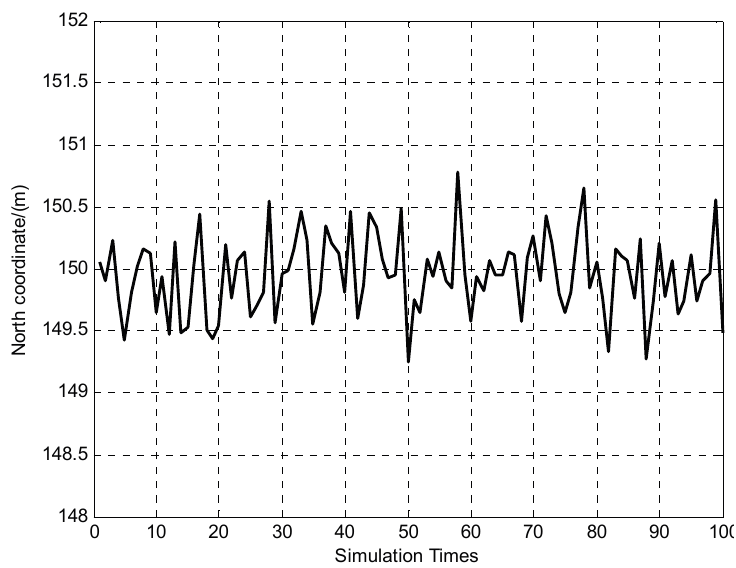
Figure 5. 100 times of north coordinate determination results.